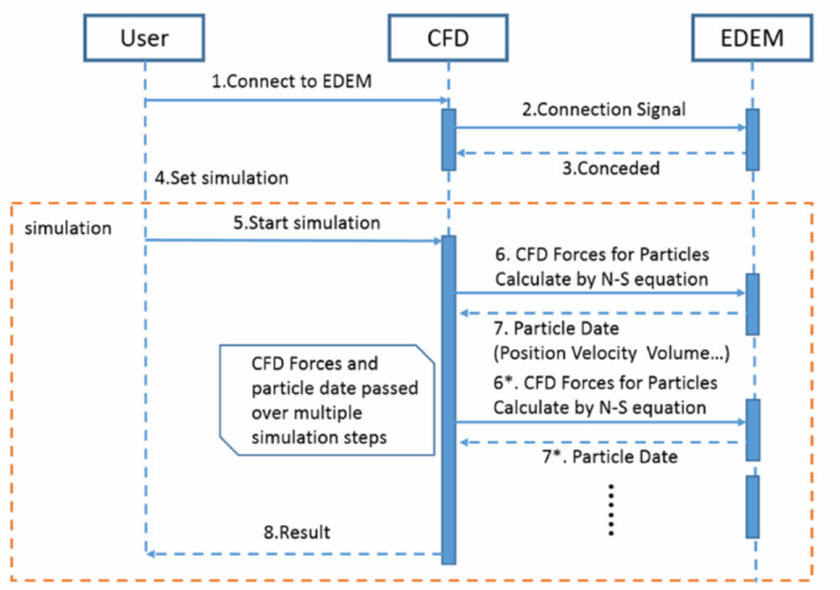
Figure 3. Schematic diagram of CFD-DEM coupling method.